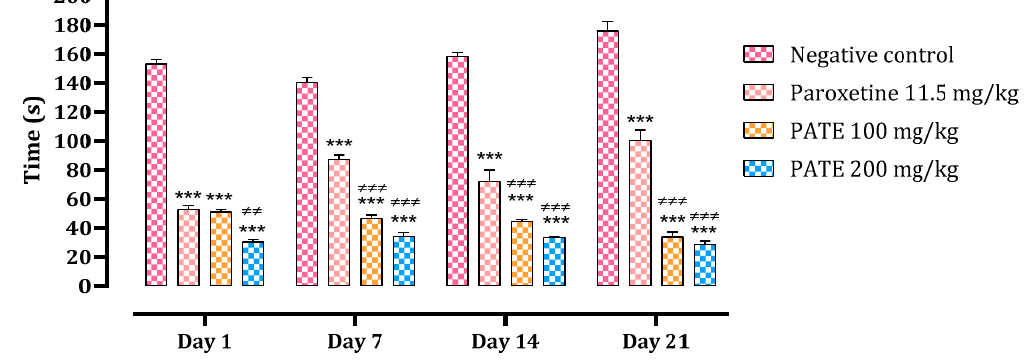
Figure 2. The effect of PATE on the immobility time variation in mice. Data are represented as mean ± SEM. (*** p ≤ 0.001 compared to negative control, ≠≠ p ≤ 0.01, ≠≠≠ p ≤ 0.001 compared to positive control).